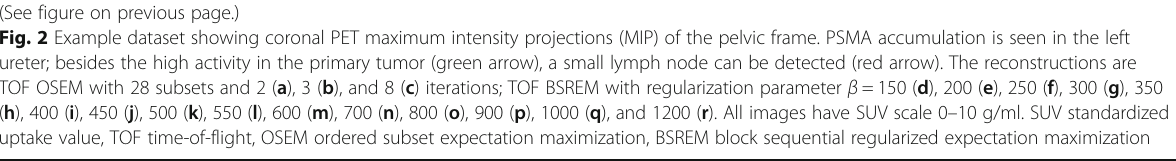
The effect of β on lesion SUVmax and CR is shown in Fig. 4 for the 3 lesion subgroups: small size, low uptake; medium size, medium uptake; and large size, high up- take. A low β value of up to 350 will result in higher SUVmax values compared to the reference TOF OSEM, but also in higher image noise (Fig. 3 and Table 1). These reconstructed images are not clinically useful as the noise renders the lesions indistinguishable from background noise. A β value between 400 and 550 will, on average, result in higher or approximately equal SUV- max compared to the reference, with nearly equal or lower background noise (Fig. 4 and Table 1). A β value higher than 600 will result in not only lower SUVmax values but also lower background noise. The “ L ” in Fig. 4